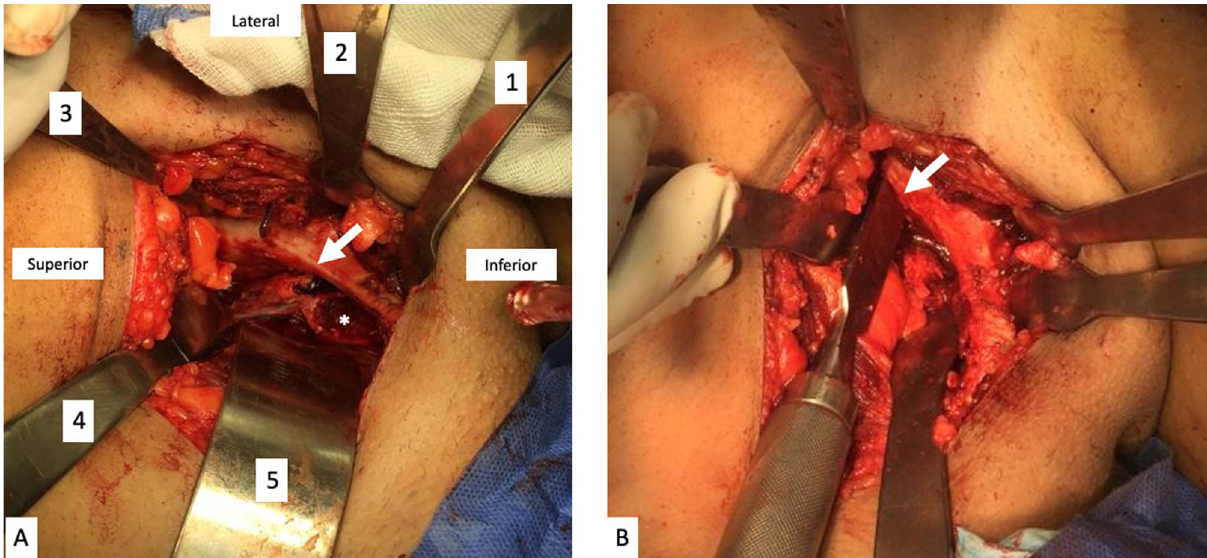
Figure 2. (A) Exposure of the quadrilateral surface of the left hemi-pelvis. Placement of retractors (1) behind the iliopectineal eminence, (2) middle of ilium, (3) in front of sacroiliac joint, (4) greater sciatic notch, (5) retracting peritoneum and bladder. Pelvic brim (arrow), obturator internus muscle (asterisk). (B) Performing the posterior vertical cut